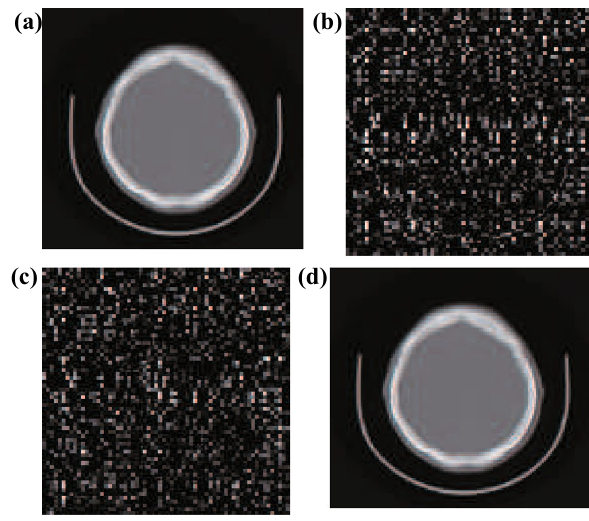
Fig. 3 Medical image encryption and decryption results: (a) Original medical image, (b) Encrypted medical image, (c) Decrypted medical image with a tiny changed initial values and control parameters, (d) Decrypted image with correct